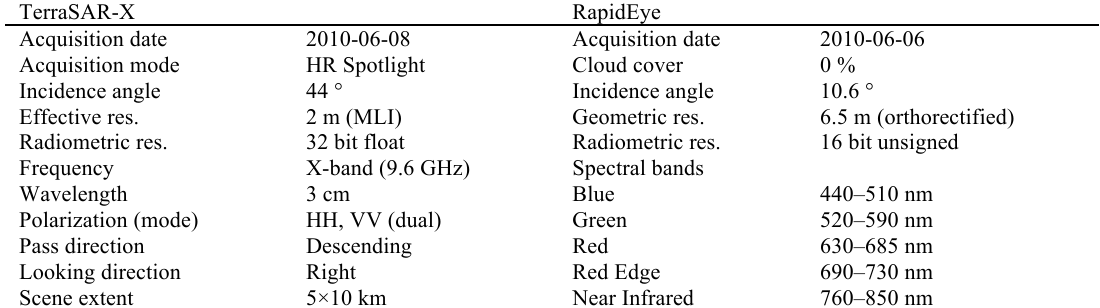
Tab. 1 Characteristics of the TerraSAR-X (left) and RapidEye data